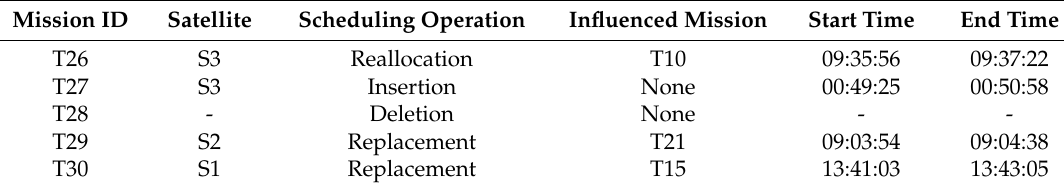
Table 12. Scheduling plan of newly arrived